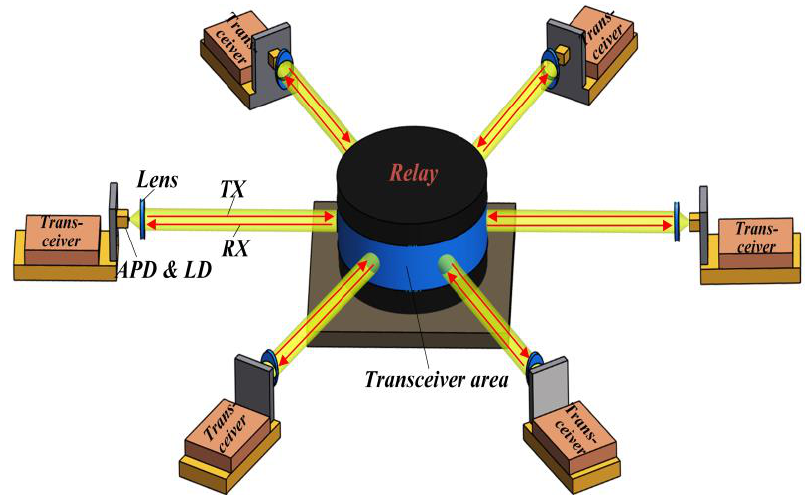
Figure 4. Schematic diagram of the structure of the laser relay station networking system.